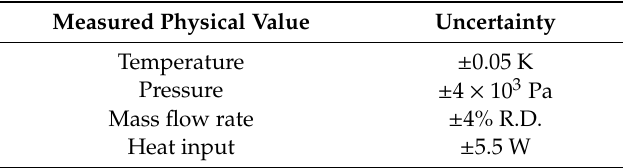
Table 1. Measurement